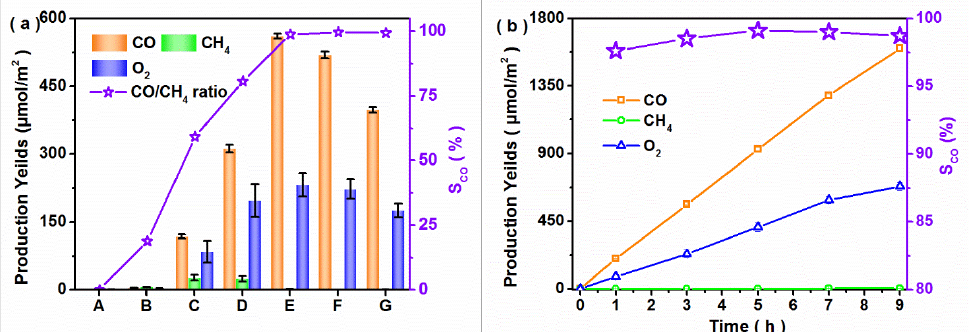
Figure 4. Photocatalytic activity for different samples under visible-light illumination (( a ) A. CBO, B. CuO, C. 10CBO/CuO, D. 20CBO/CuO, E. 30CBO/CuO, F. 40 CBO/CuO, G. 50CBO/CuO. ( b ) 30CBO/CuO as catalyst).